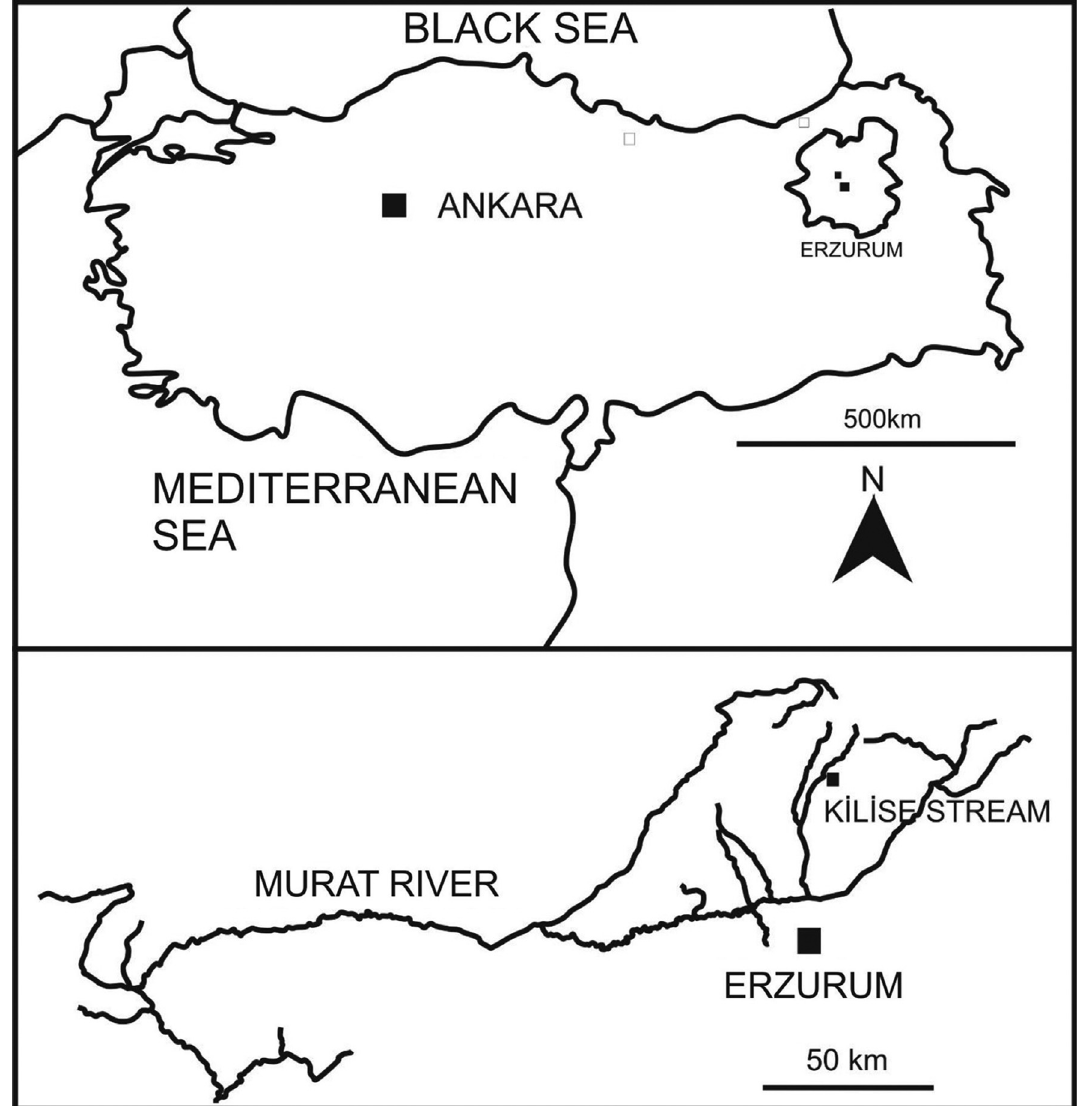
Figure 1. Collection site of Echinorhynchus baeri from Salmo trutta in the Kilise Stream, Murat River,